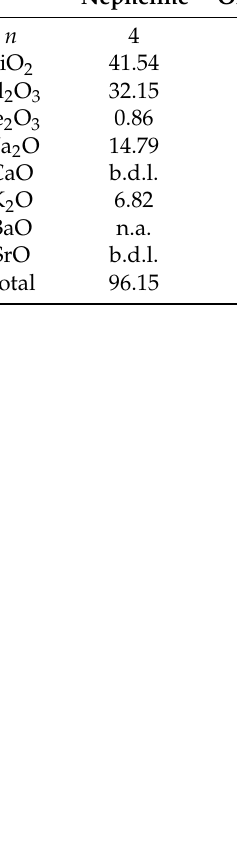
Table 2. Chemical composition (wt.%) of clinopyroxene. Fine-Grained Zone Yellowish-Green to